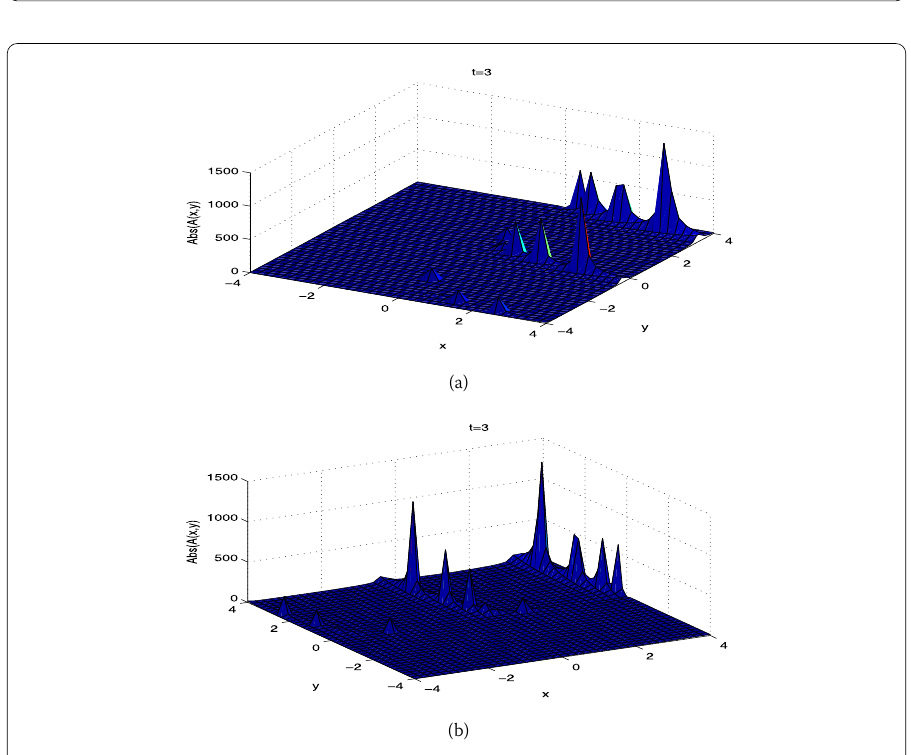
Figure 4 ( a ) The exact solution represented by Eq. (78), t = 3, α = 1, β = 0.25, γ = 1. ( b ) The exact solution represented by Eq. (78), t = 3, α = 1, β = 1, γ =